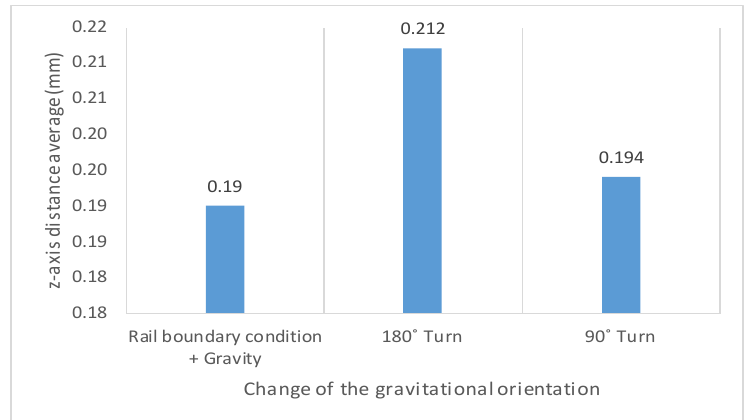
Figure 17. 𝐴 𝑑𝑖𝑠𝑡𝑎𝑛𝑐𝑒 with the change in gravitational orientation.